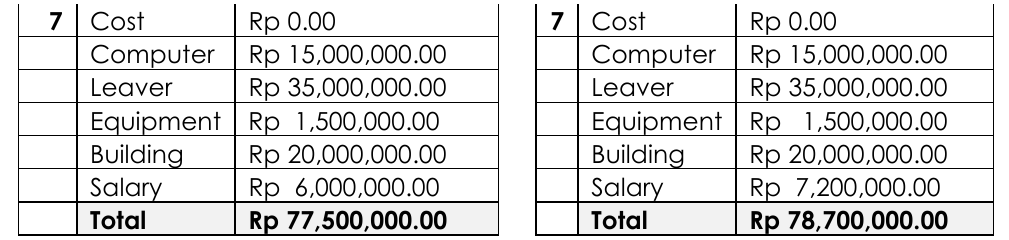
Table 8. Additional Costs Server with or Without the Addition of One Worker In